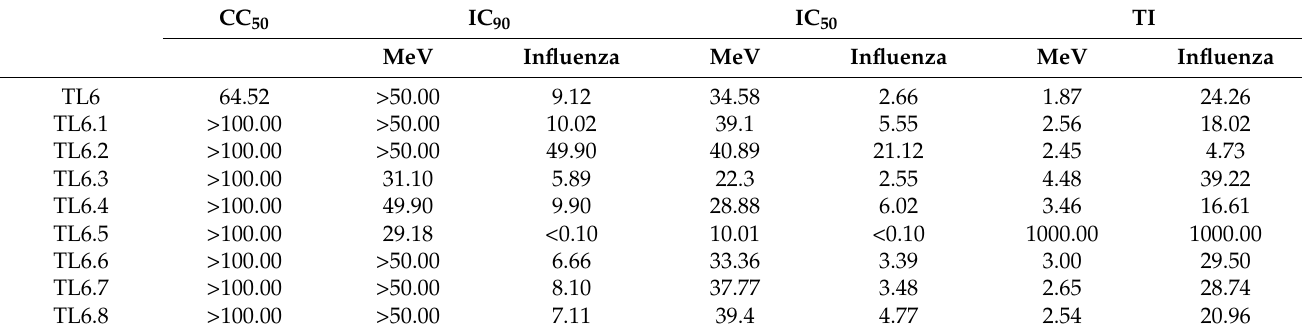
Table 7. CC 50 , IC 90 , IC 50 and TI calculated for Mev and influenza virus. Concentrations are expressed in µ